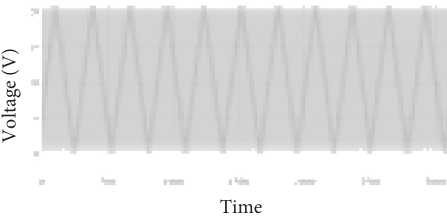
Figure 25: Voltage across the node.